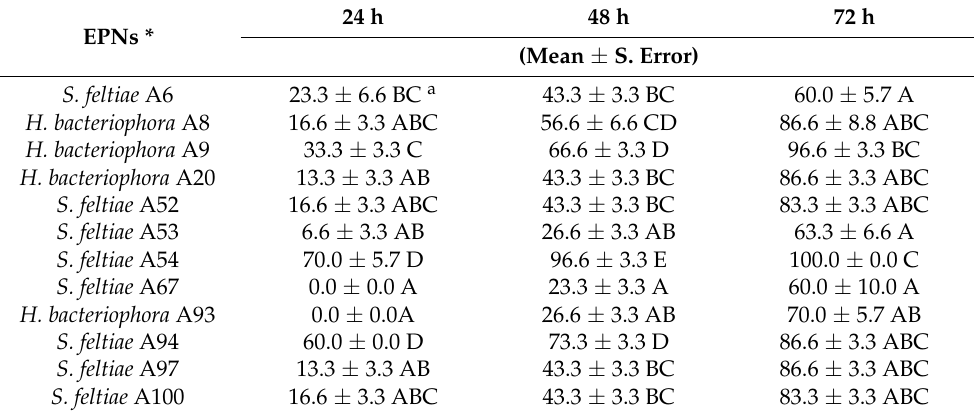
Table 4. Mortality rates (%) of isolated entomopathogenic nematodes on the last instar larvae of Galleria mellonella at concentrations of 100 infective juveniles/Petri dish (100 IJs/Petri) under laboratory conditions (25 ◦ C, 60%